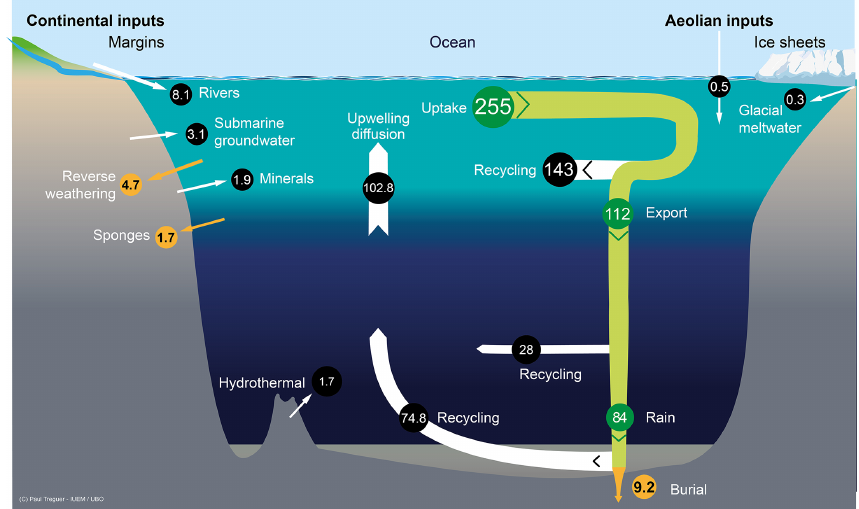
Figure 1. Schematic view of the Si cycle in the modern world ocean (input, output, and biological Si fluxes), and possible balance (total Si inputs = total Si outputs = 15 . 6Tmol Siyr − 1 ) in reasonable agreement with the individual range of each flux ( F ); see Tables 1 and 2. The white arrows represent fluxes of net sources of silicic acid (dSi) and/or of dissolvable amorphous silica (aSi) and of dSi recycled fluxes. Orange arrows correspond to sink fluxes of Si (either as biogenic silica or as authigenic silica). Green arrows correspond to biological (pelagic) fluxes. All fluxes are in teramoles of silicon per year (Tmol Siyr − 1 ). Details are given in Sect. S1 in the